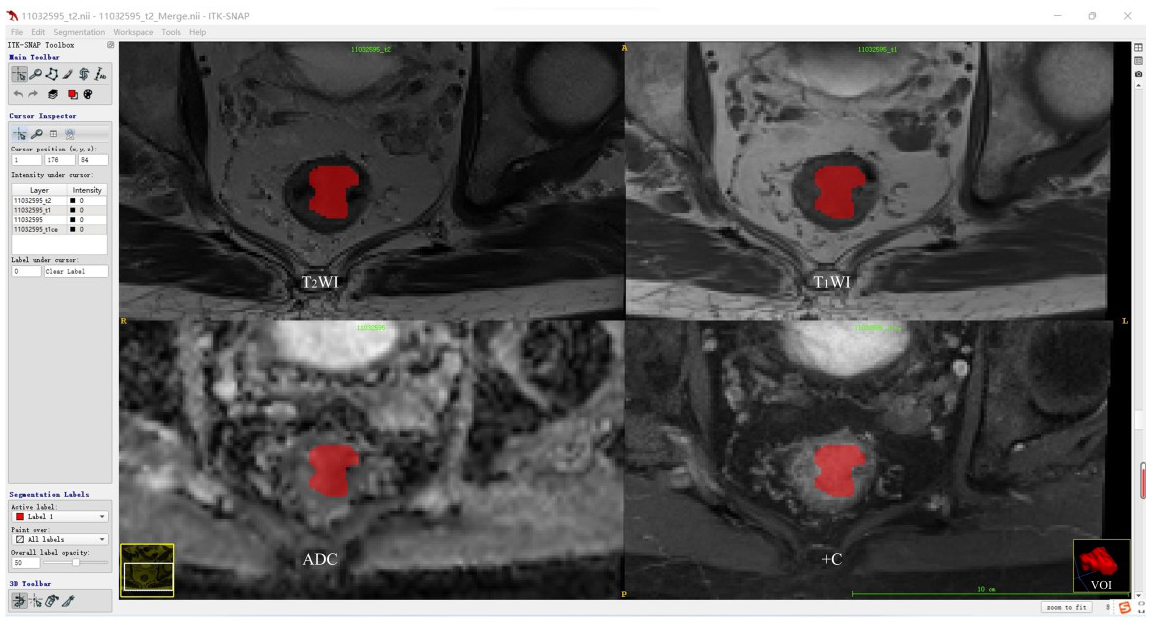
Figure 2. Tumor segmentation procedure.